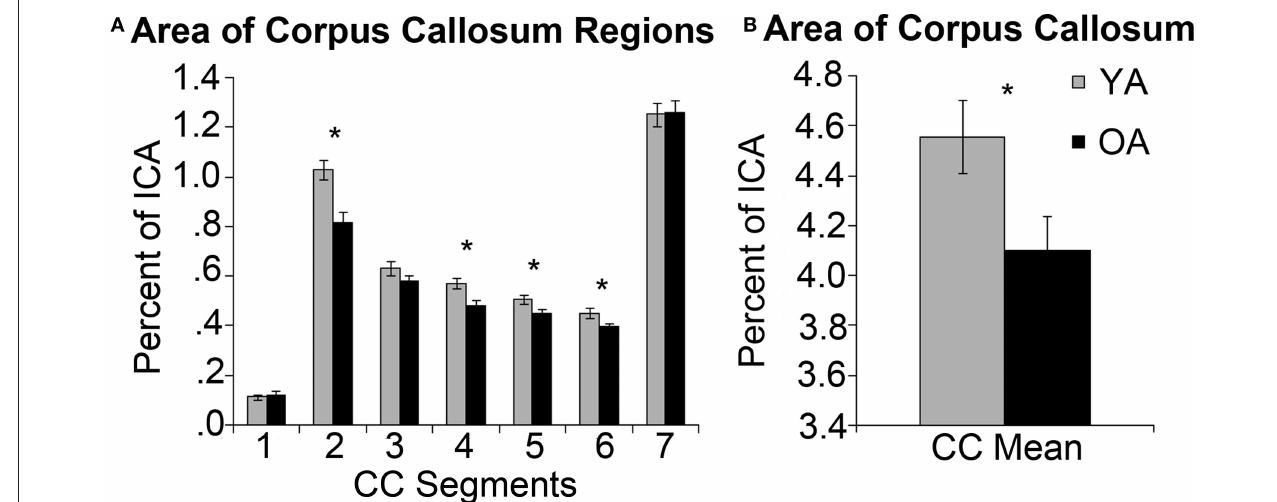
FIguRe 8 | (A) Normalized area of CC regions and standard error (SE) in young adults (YA) and older adults (OA). The CC is divided into seven regions: (1) rostrum, (2) genu, (3) rostral truncus, (4) anterior intermediate truncus,